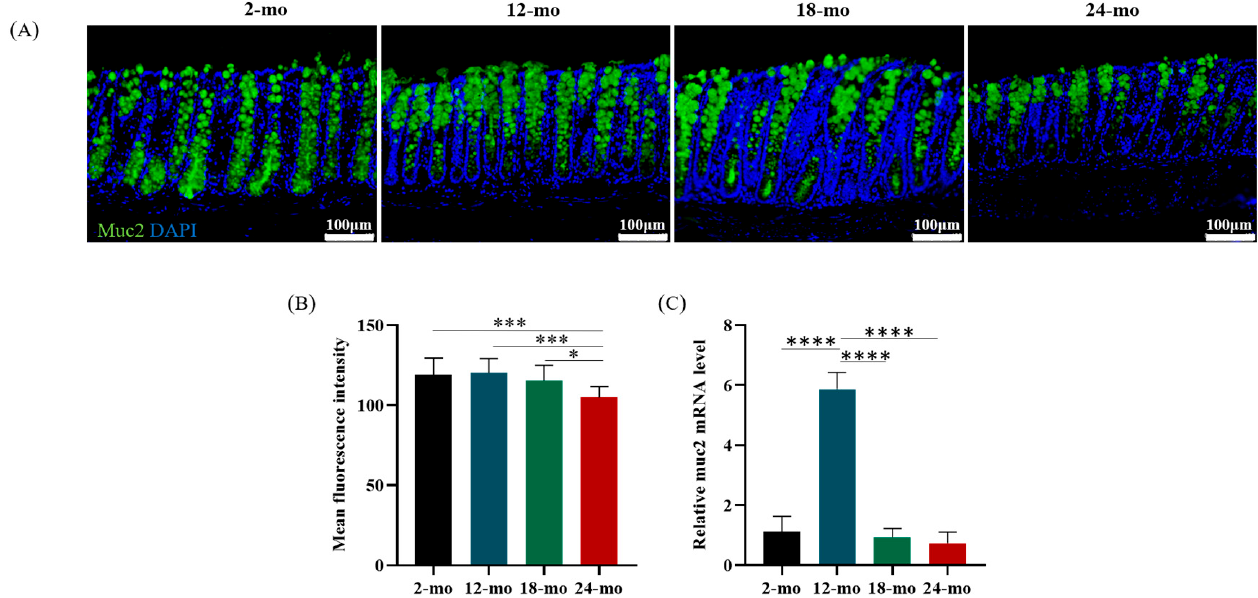
Figure 4. Muc2 mucin content of the mucus layer of colon in aging mice. ( A ) Immunofluorescence staining of 2-, 12-, 18- and 24-month-old mouse colon sections with anti-Muc2 (in green; cell nuclei in blue). Scale bars: 100 µ m. Immunofluorescence results of Muc2 mucin ( B ) and relative mRNA expression ( C ) of Muc2 in the mouse colon. Data were presented as mean ± SD. Data were statistically analyzed using one-way ANOVA with Tukey’s post hoc test. Asterisk indicates significant difference, * p < 0.05, *** p < 0.001, **** p < 0.0001, n = 3 per group.